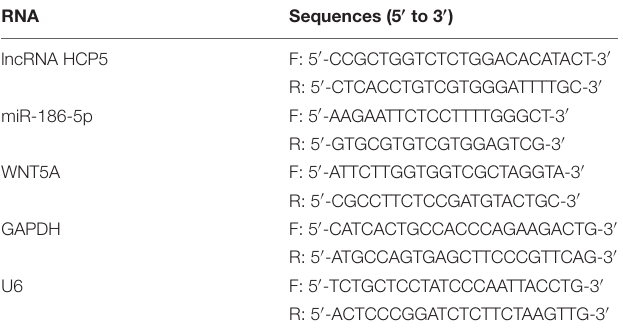
TABLE 1 | Primer sequences.